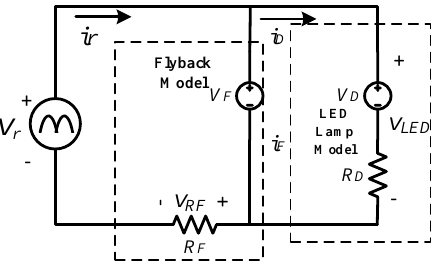
Figure 4. Equivalent circuit for low-frequency analysis.